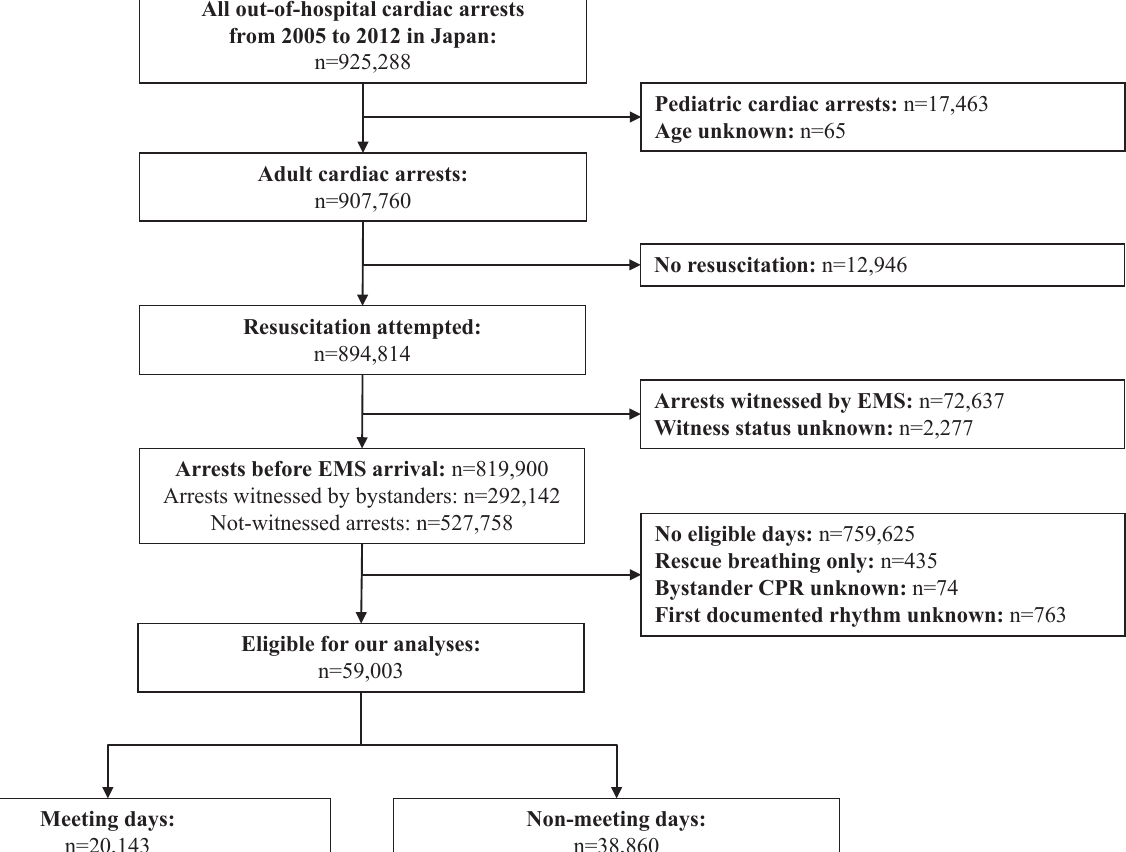
Figure. Study fl ow of pediatric out-of-hospital cardiac arrest cases with an abridged Utstein template from January 1, 2005 through December 31, 2012. EMS, emergency medical service; CPR, cardiopulmonary